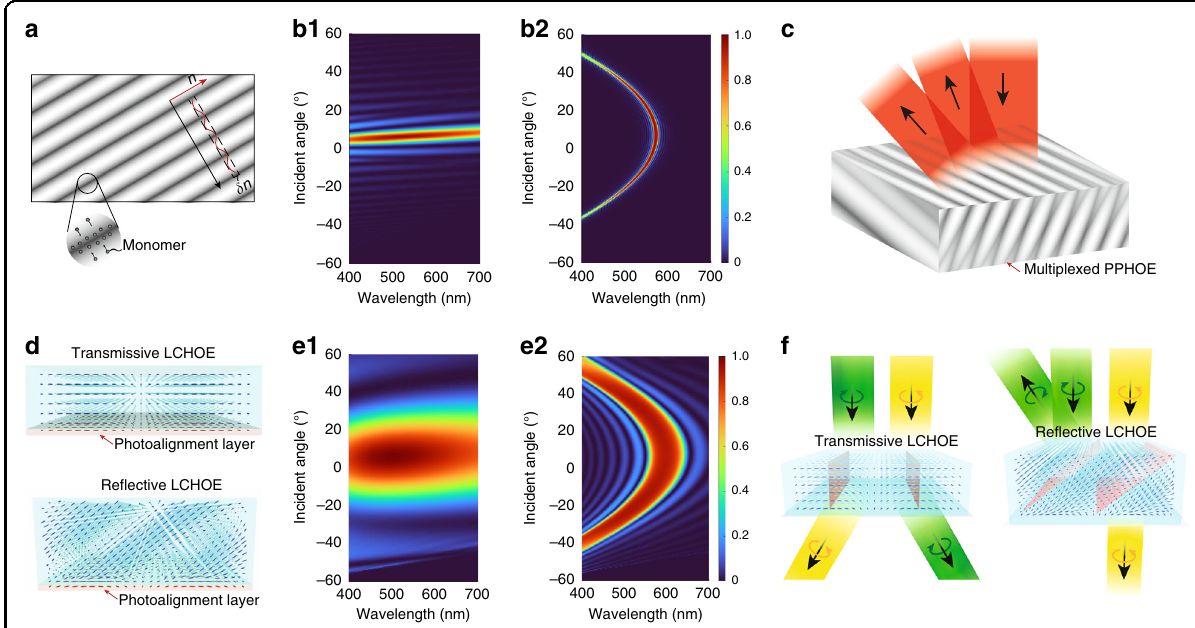
Fig. 3 Formation and properties of HOEs. a Schematic of the formation of PPHOE. Simulated ef fi ciency plots for b1 transmissive and b2 re fl ective PPHOEs. c Working principle of multiplexed PPHOE. d Formation and molecular con fi gurations of LCHOEs. Simulated ef fi ciency plots for e1 transmissive and e2 re fl ective LCHOEs. f Illustration of polarization dependency of